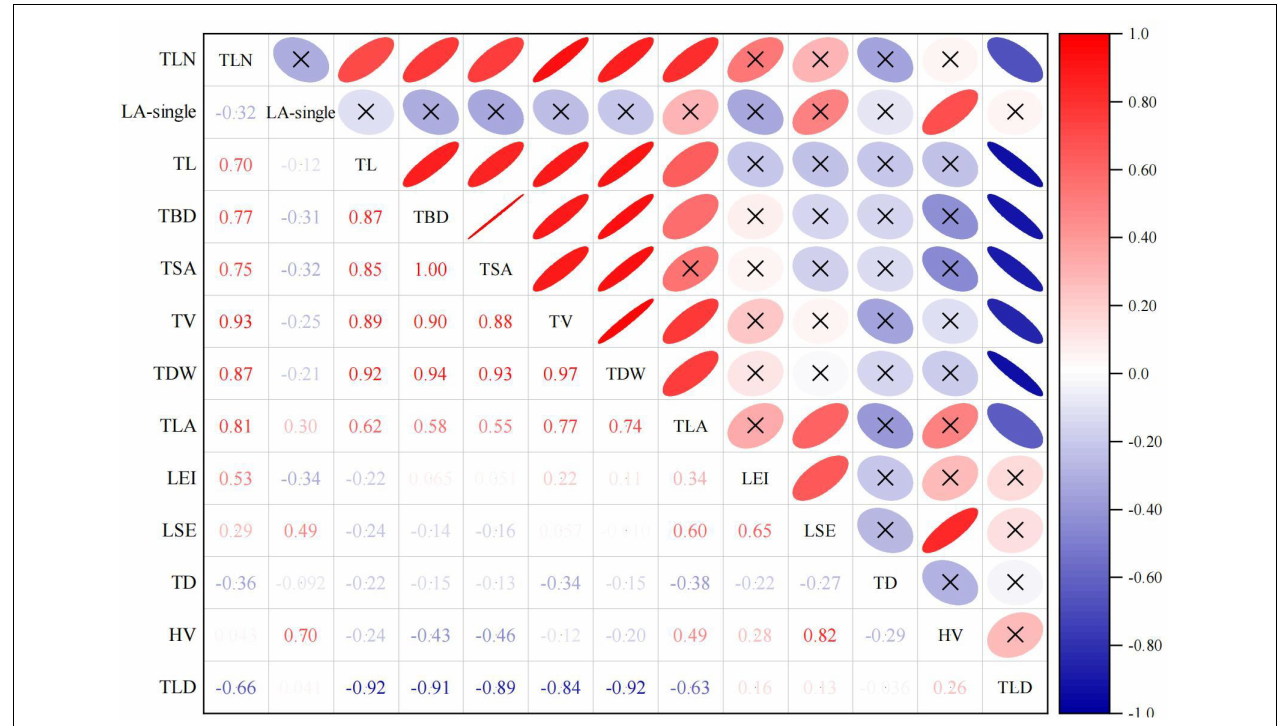
FIGURE 5 | Relationships between functional traits of current year twigs